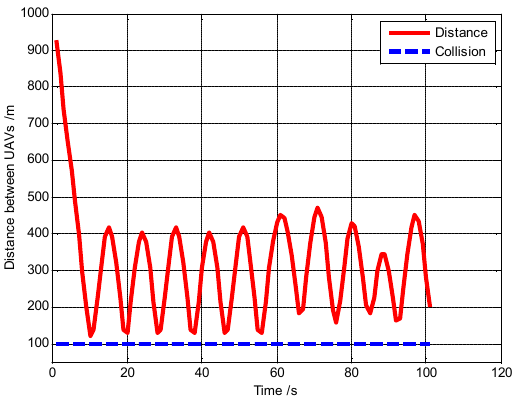
Figure 16. The trace of the FIM for A 1 , A 2 and base station (Group B in Scenario 1).